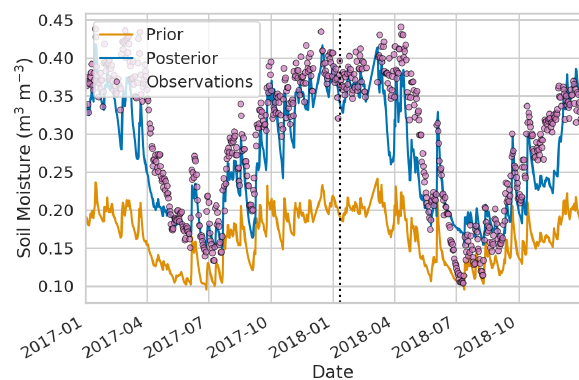
Figure 3. Observed and modelled (ensemble mean) soil moisture time series at Bickley Hall (BICKL). The dotted line separates the period over which observations have been used for assimilation (2017) from the period in which no observations have been assimi- lated